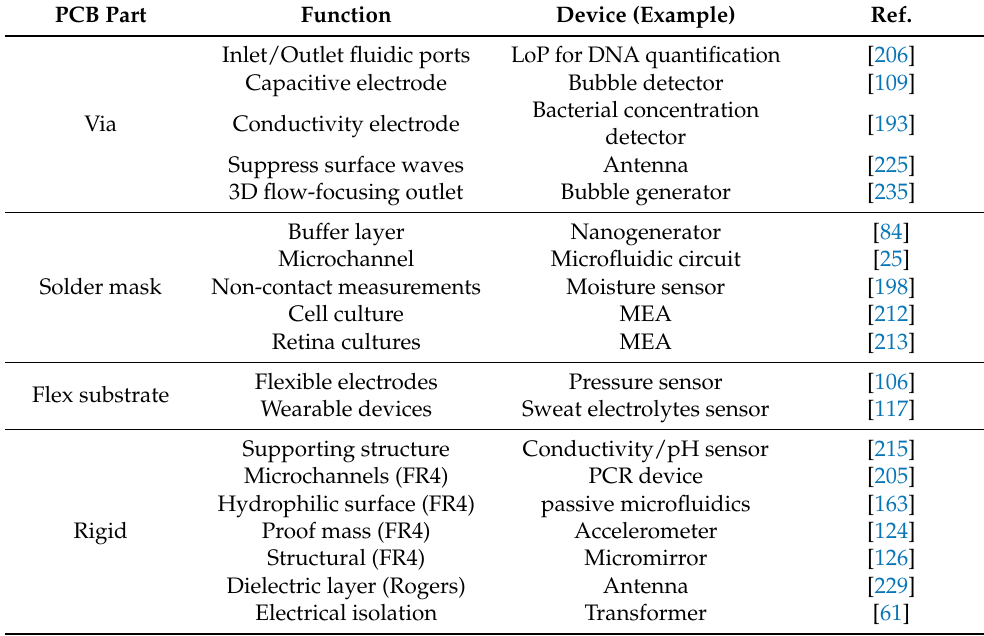
Table 2. Vias, solder mask, flexible and rigid substrate functions and